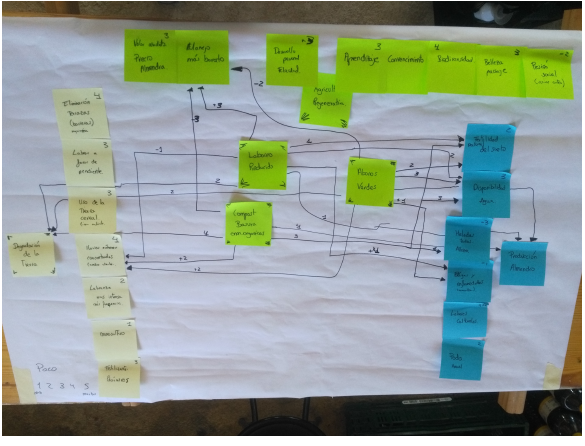
Fig. 2. Example of a fuzzy cognitive map constructed with a participating farmer in summer